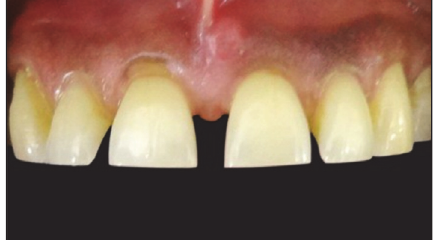
Figure 2: Preoperative intraoral view of maxillary anterior regions.